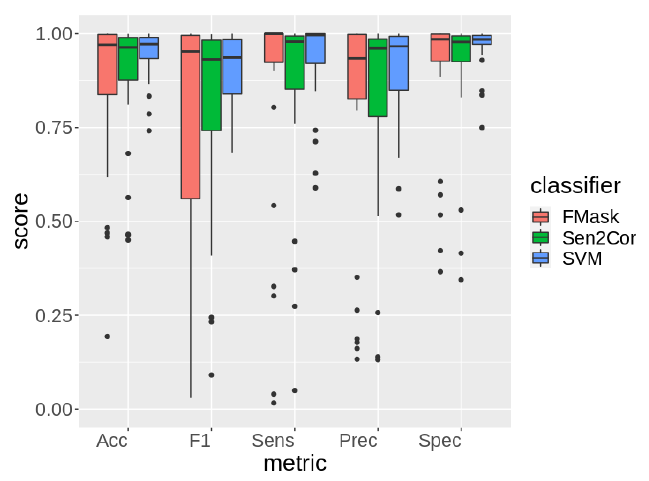
Figure 4. Performance comparison of FMask, Sen2Cor and SVM.